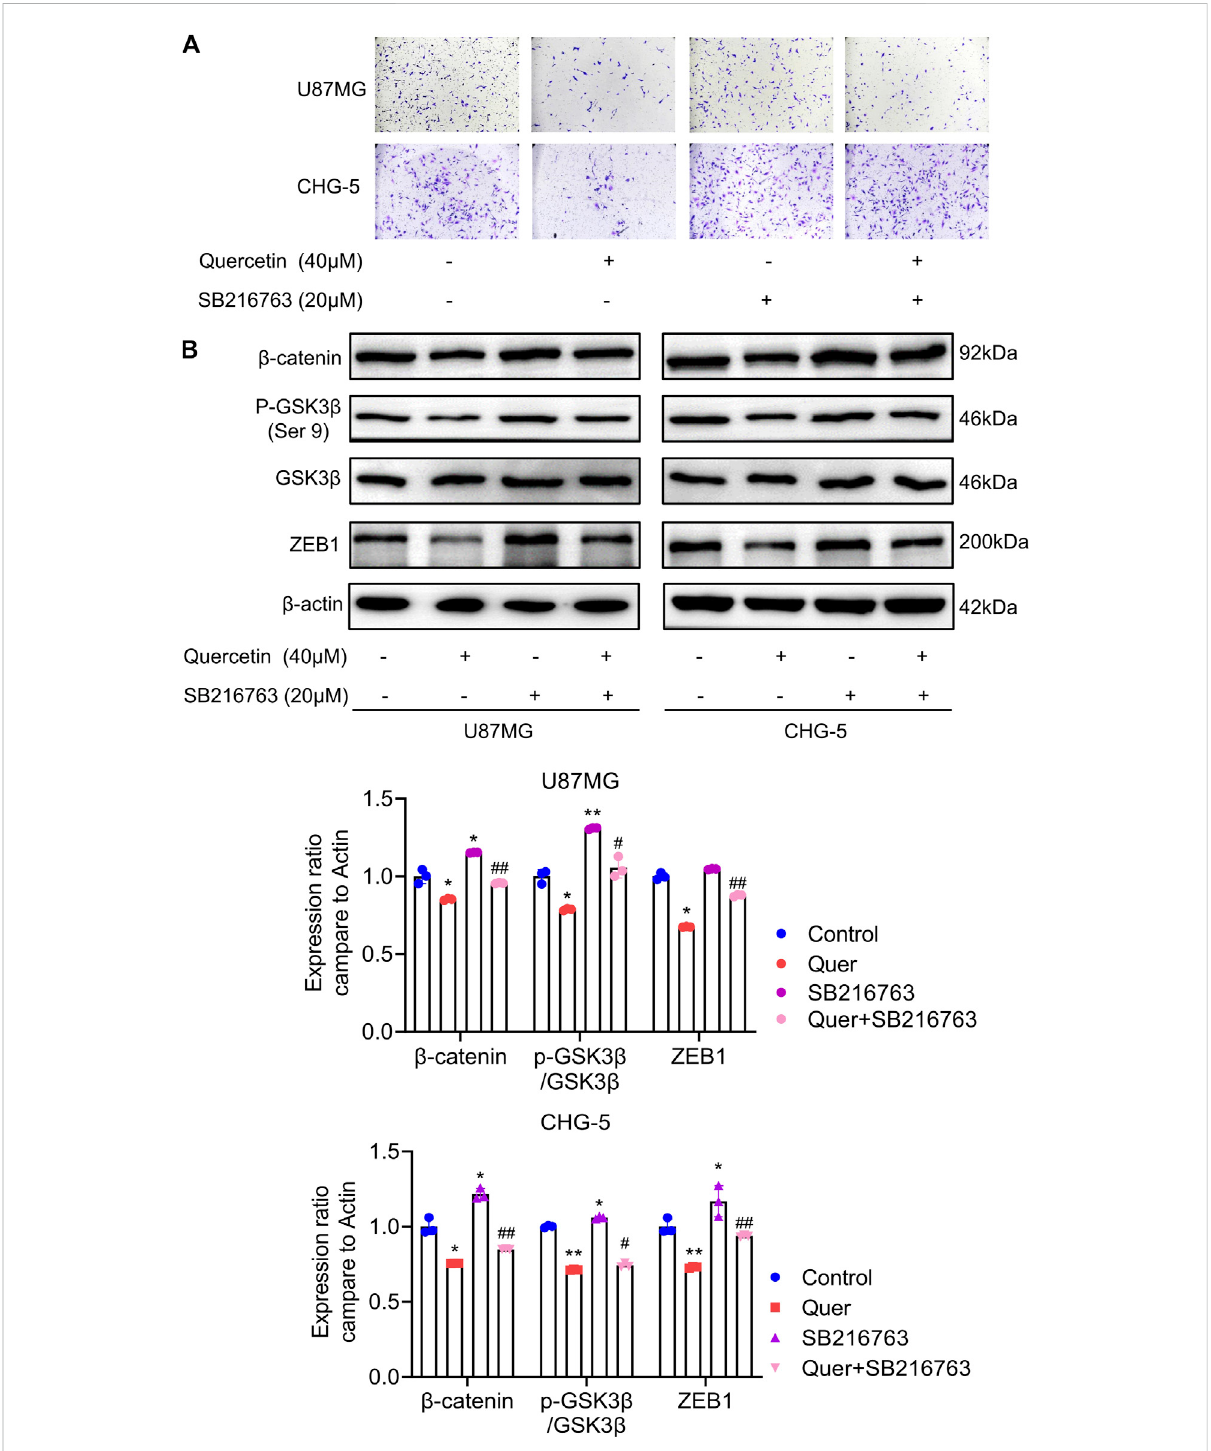
FIGURE 7 Quercetin inhibits EMT-like mesenchymal transition and invasion through GSK-3 β / β -catenin/ZEB1signaling. (A) The cell invasion ability of U87MG and CHG-5 cells was assessed by transwell assay after treatment with quercetin alone or combined with SB216763. (B) Western blotting analysis of the expression of p-GSK-3 β (Ser 9), GSK-3 β , β -catenin, and ZEB1 after treatment with quercetin alone or combined with SB216763 in U87MG and CHG-5 cells. The data are shown as the mean ± SD of three experiments. * p ＜ 0.05, ** p ＜ 0.01 vs. control